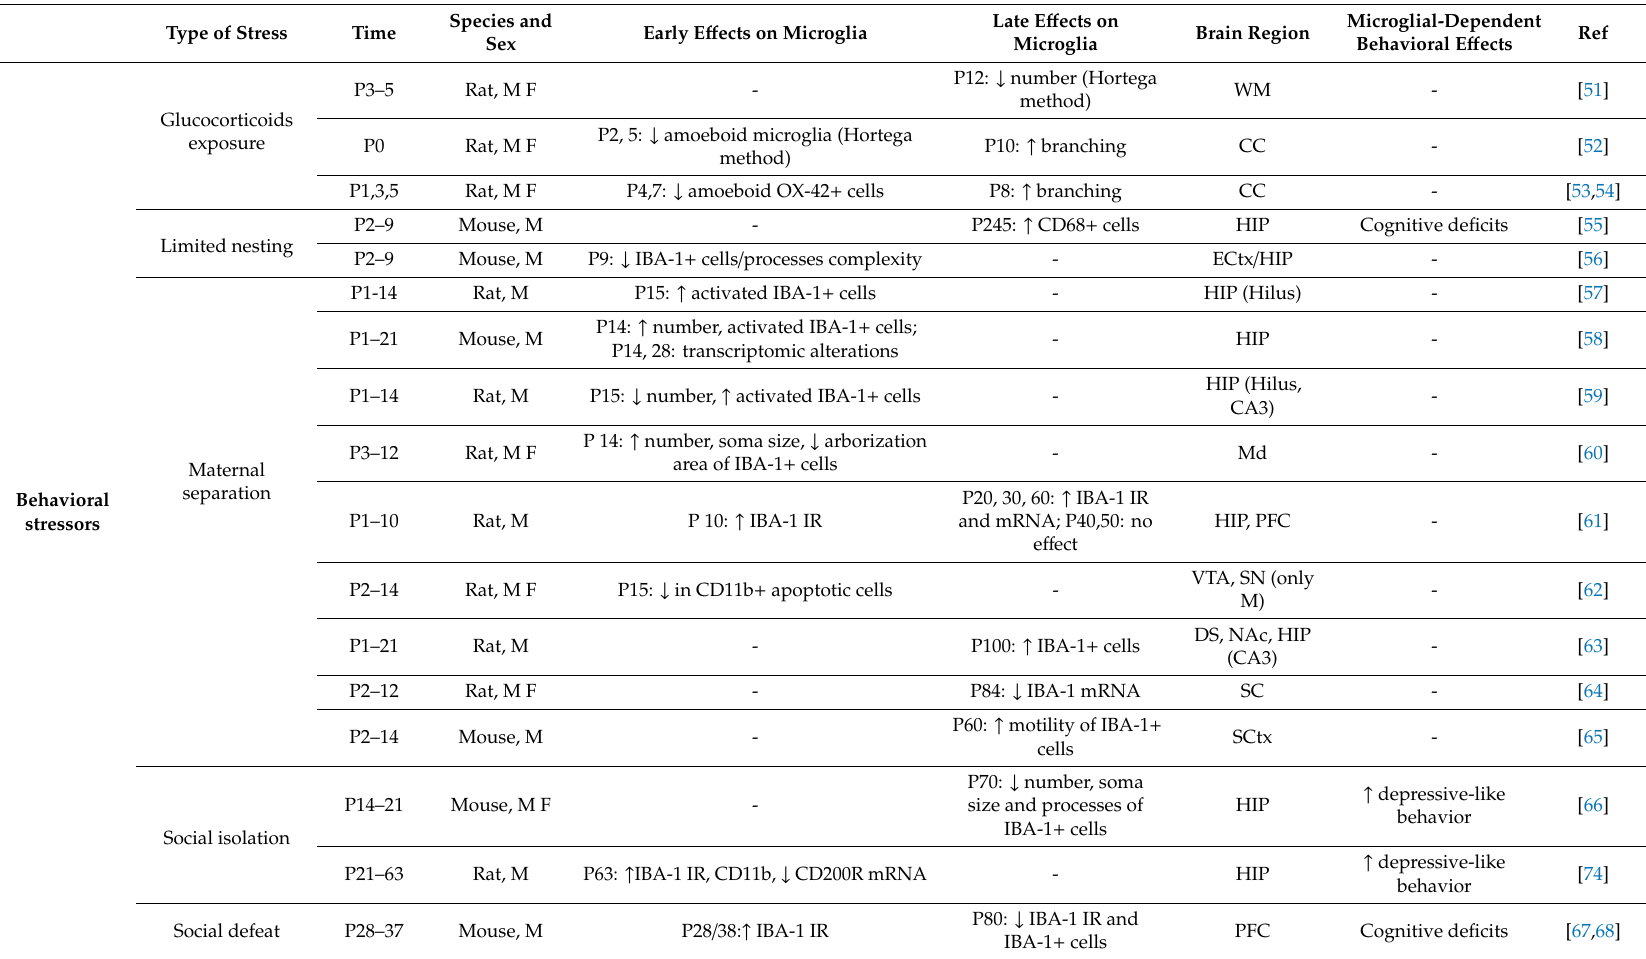
Table 2. E ff ects of postnatal behavioral stressors on microglial cell density and phenotype and subsequent behavioral alterations. Type of Stress